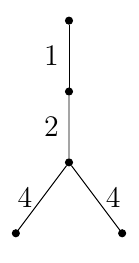
Figure 7: The rooted trees in which the root has degree 1 are known as planted trees. It is an example of planted, equidistant tree satisfying equality (4.2) with K = 7. The following proposition gives us a tool for the investigation of a duality between equidis- tant trees and monotone